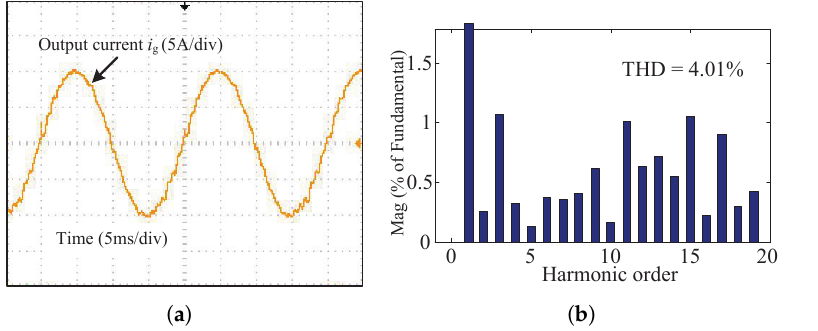
Figure 10. PIMR-type RC ( m = 3) control system with k r = 1: ( a ) The output current waveform; ( b ) The output current spectrum analysis.